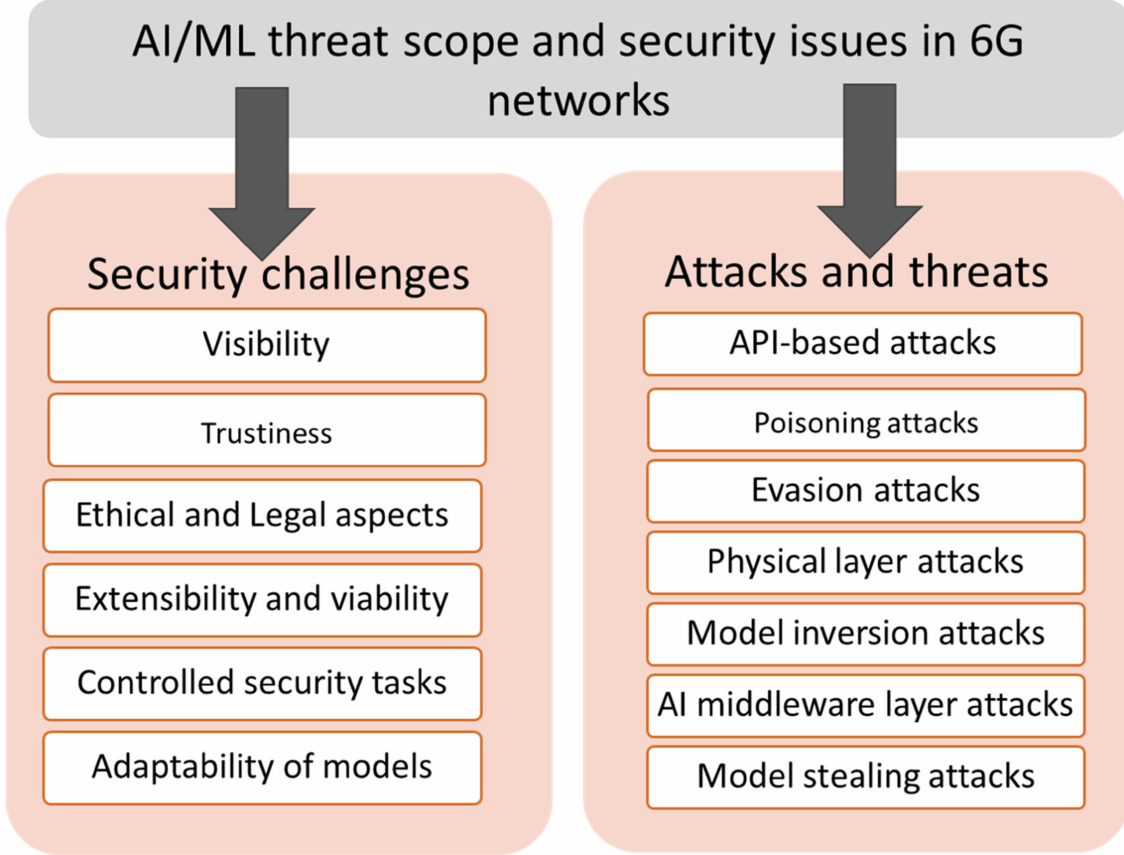
Figure 7. The 6G AI/ML security challenges and threat